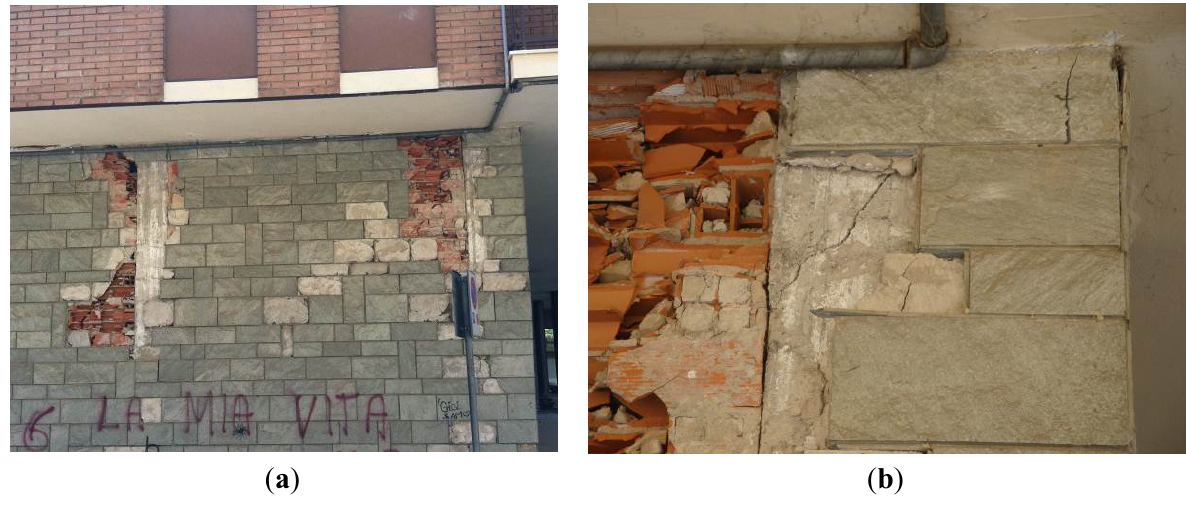
Figure 13. ( a ) Damage to infill masonry walls; ( b ) Diagonal crack propagation from infill wall to RC column.